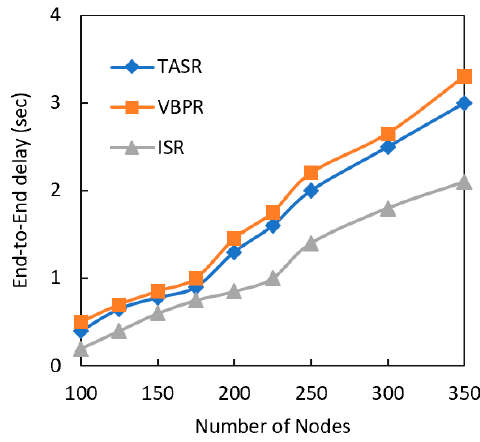
Figure 6. Comparison of end-to-end delay with increasing number of vehicular nodes.